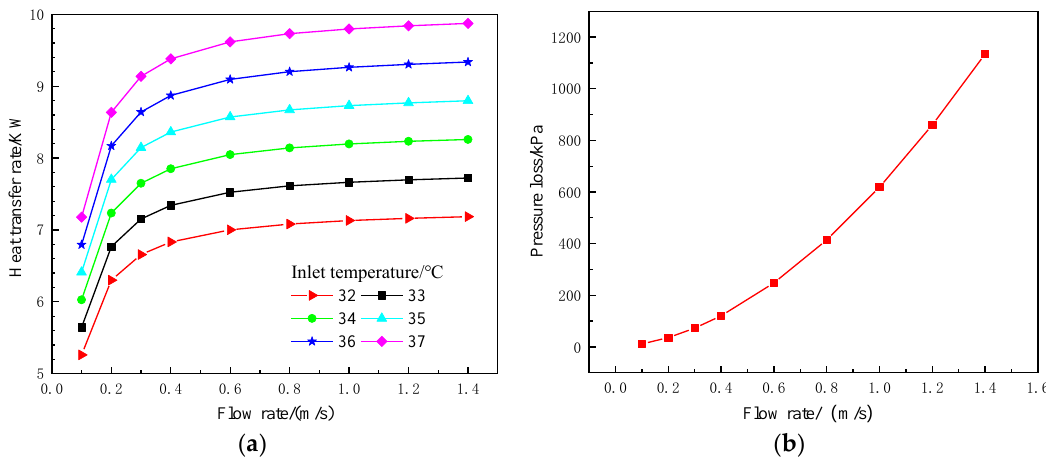
Figure 18. Change of heat transfer rate and pressure loss with flow rate. ( a ) Relationship between heat transfer rate and flow rate. ( b ) Relationship between pressuer loss and flow rate.